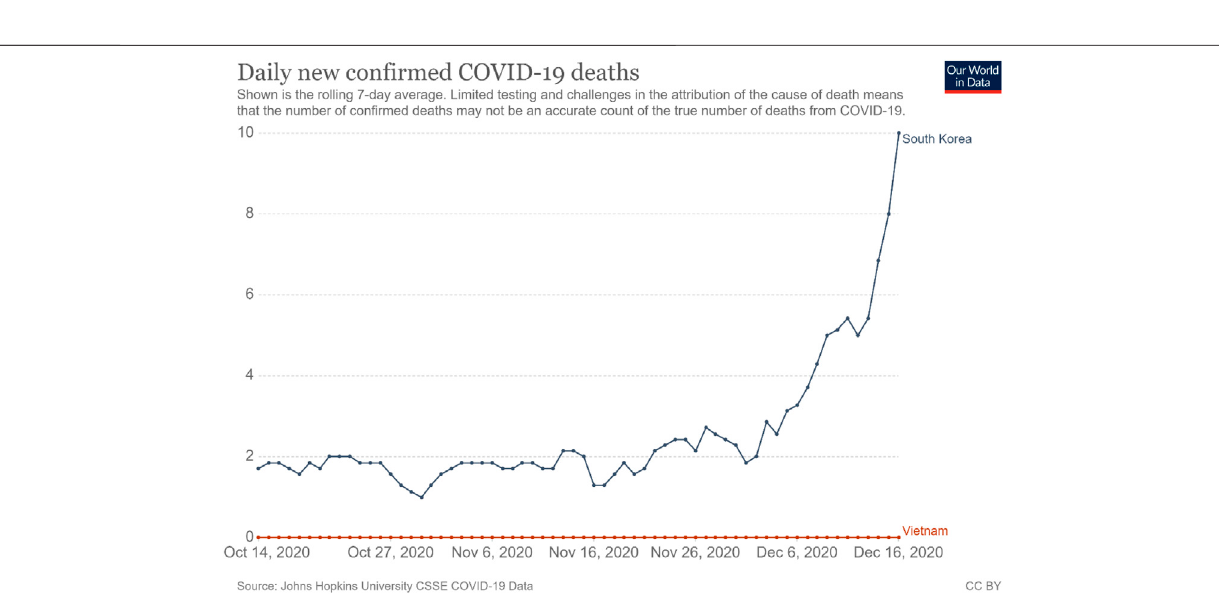
Frontiers in Communication |